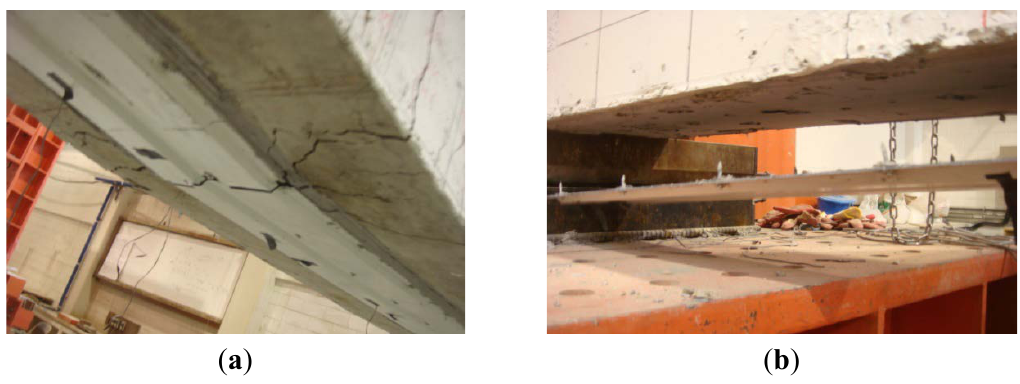
Figure 6. Failure modes of strengthening specimens of ( a ) fracture of AGC beam and ( b ) debonding of AGC